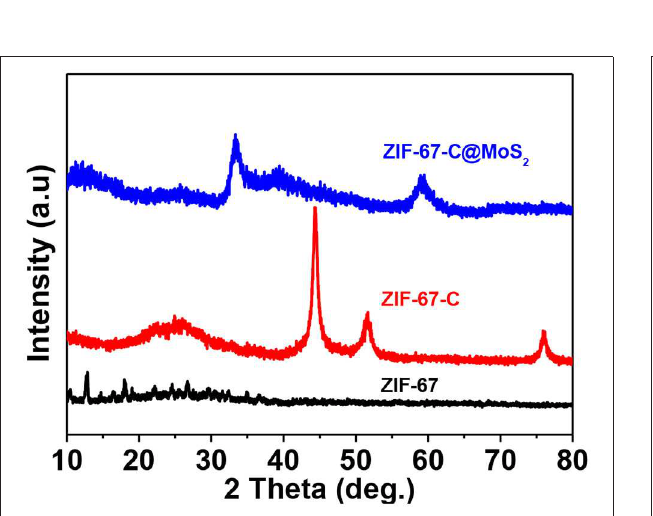
FIGURE 4 | XRD patterns of ZIF-67, ZIF-67-C, ZIF-67-C@MoS 2 samples, respectively.